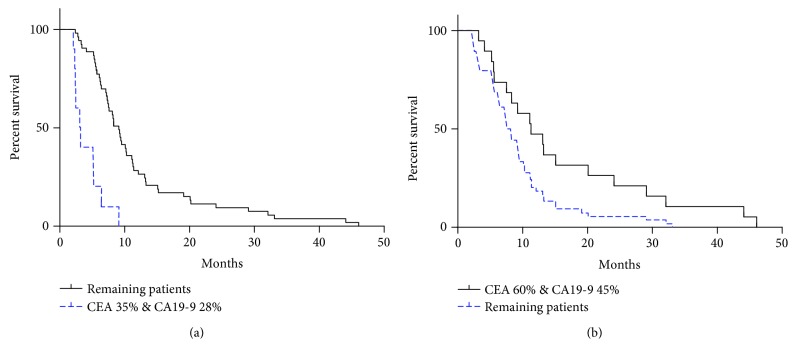
Comparisons of PFS. (a) After the third cycle of treatment, patients with a 35% increase in CEA and a 28% increase in CA19-9 had a shorter PFS compared with the remaining patients. (b) After the first cycle of treatment, patients with a decrease in CEA by 60% and a decrease in CA19-9 by 45% had a longer PFS compared with the remaining patients.